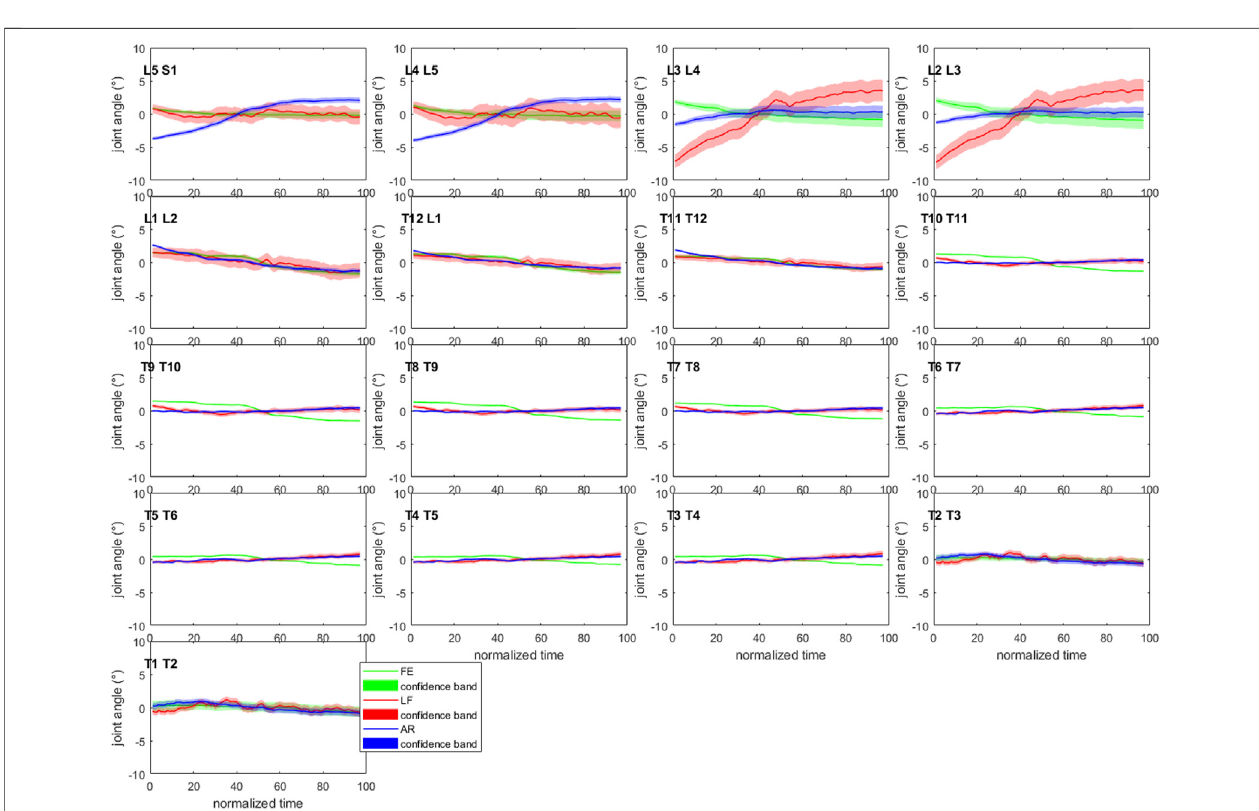
FIGURE4| Con fi dencebands(5 – 95%)foreachofthejointanglesofsubject1.Allcurveshavebeennormalizedtotheirmeanvalueoverthelengthofthemotionto allow visualizationwithinthe − 10 ° – 10 ° jointangle range. AR:axial rotation;LF: latero fl exion;FE: fl exion-extension(Graphs forS2and S3areavailablein Supplementary Material S4.5 – 4.6 of Supplementary Appendix S4